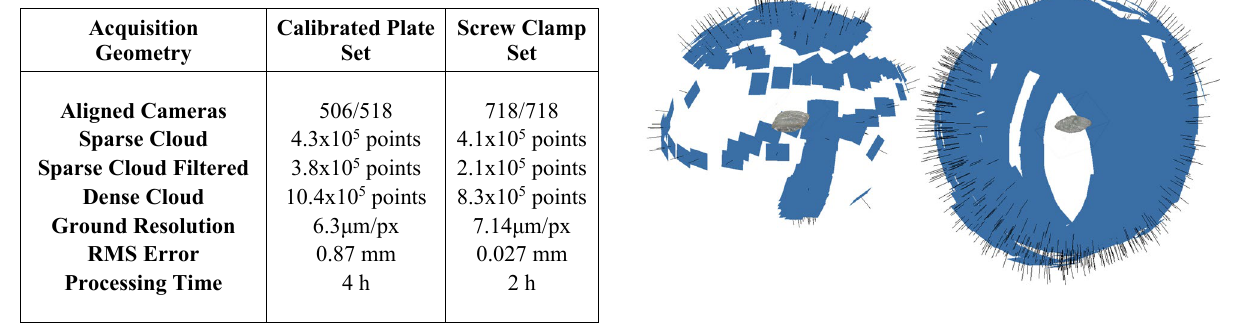
Figure 9 . Camera spatial positions during the calibrated plate (left) and screw clamp acquisition test (same time taken: